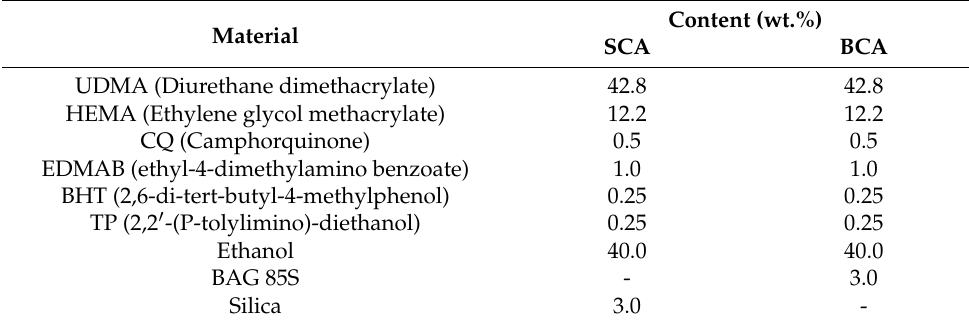
Content (wt.%) SCA BCA